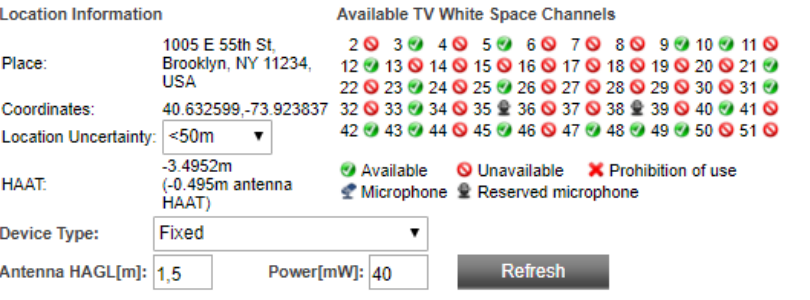
Figure 2. LS Telcom interface for querying channel availability. Parameters provided for a location in Brooklyn, New York, US